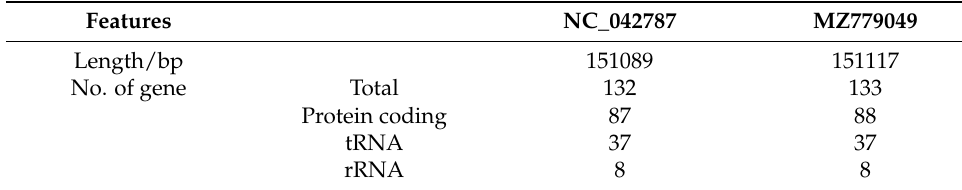
Table 3. Comparison of the cp genome features between NC_042787 and